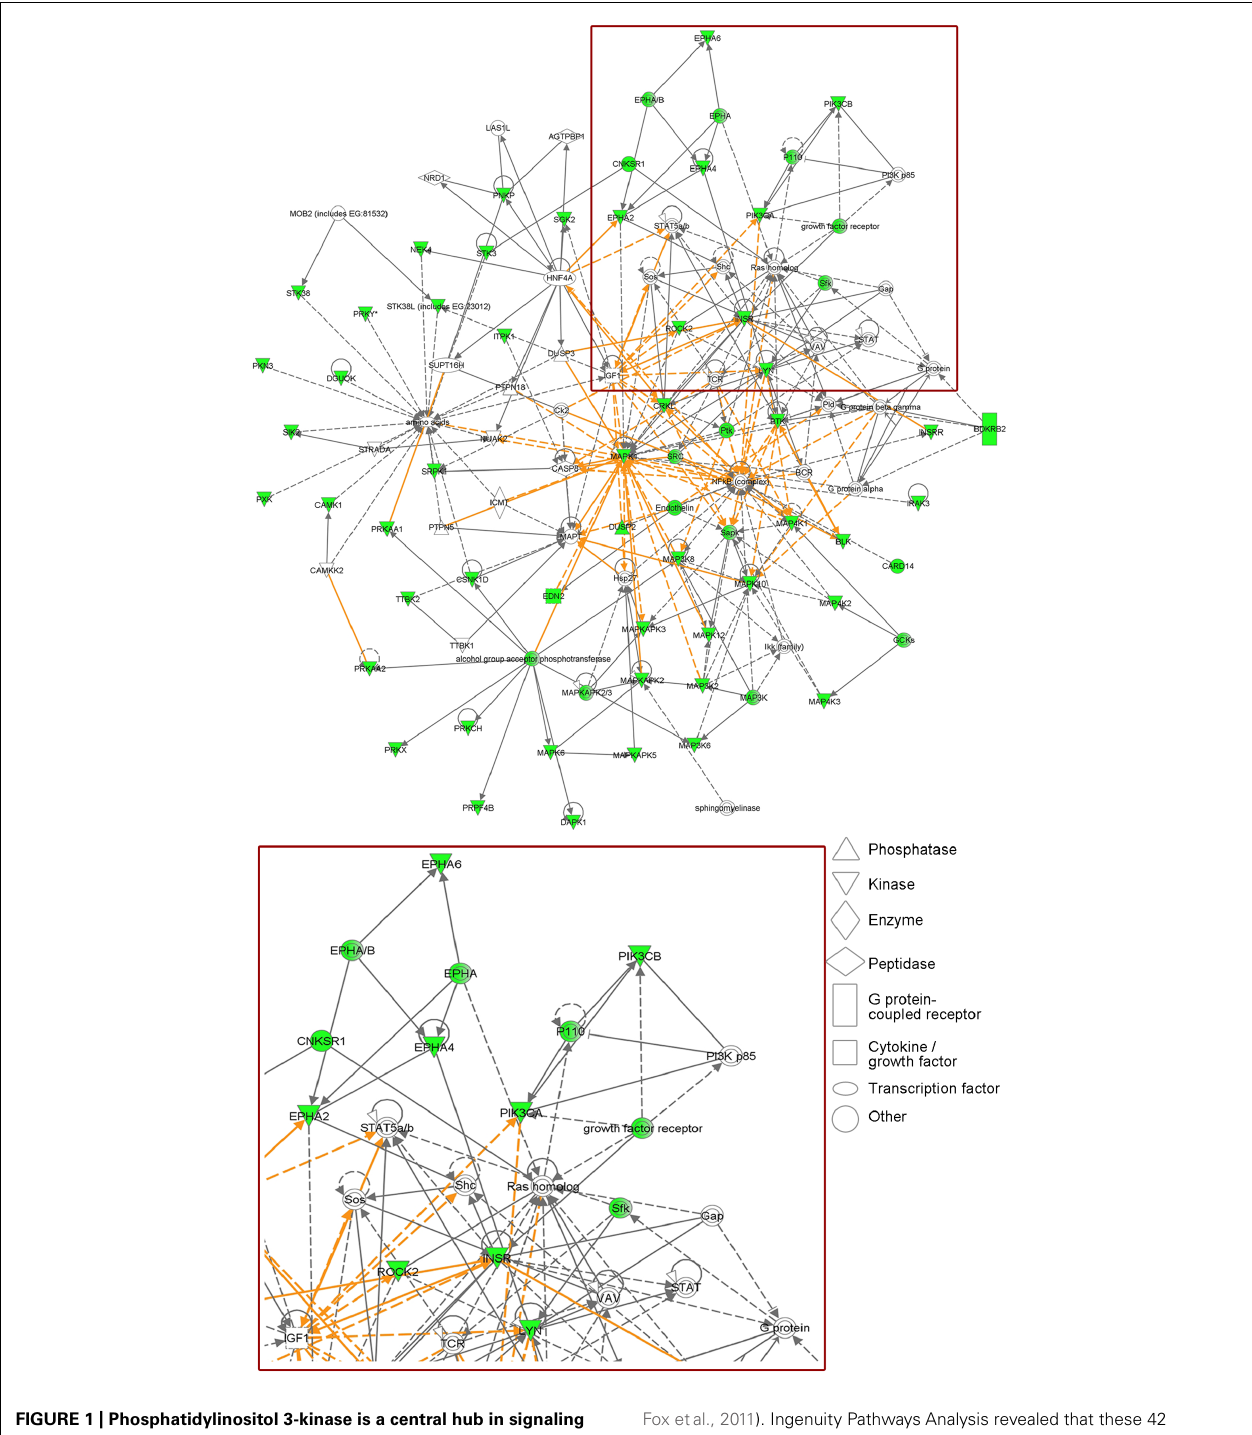
Fox etal., 2011). Ingenuity Pathways Analysis revealed that these 42 kinases map to several protein networks that overlap with PI3K signaling (red box, enlarged in bottom panel). Proteins involved in these networks are displayed as nodes. Solid lines indicate direct relationships between proteins, and dotted lines indicate indirect interactions. Green nodes represent the kinases identified in the screen, as well as others whose knockdown was predicted by the Ingenuity software to negatively affect cell growth.The various nodal shapes represent the functional class of the gene